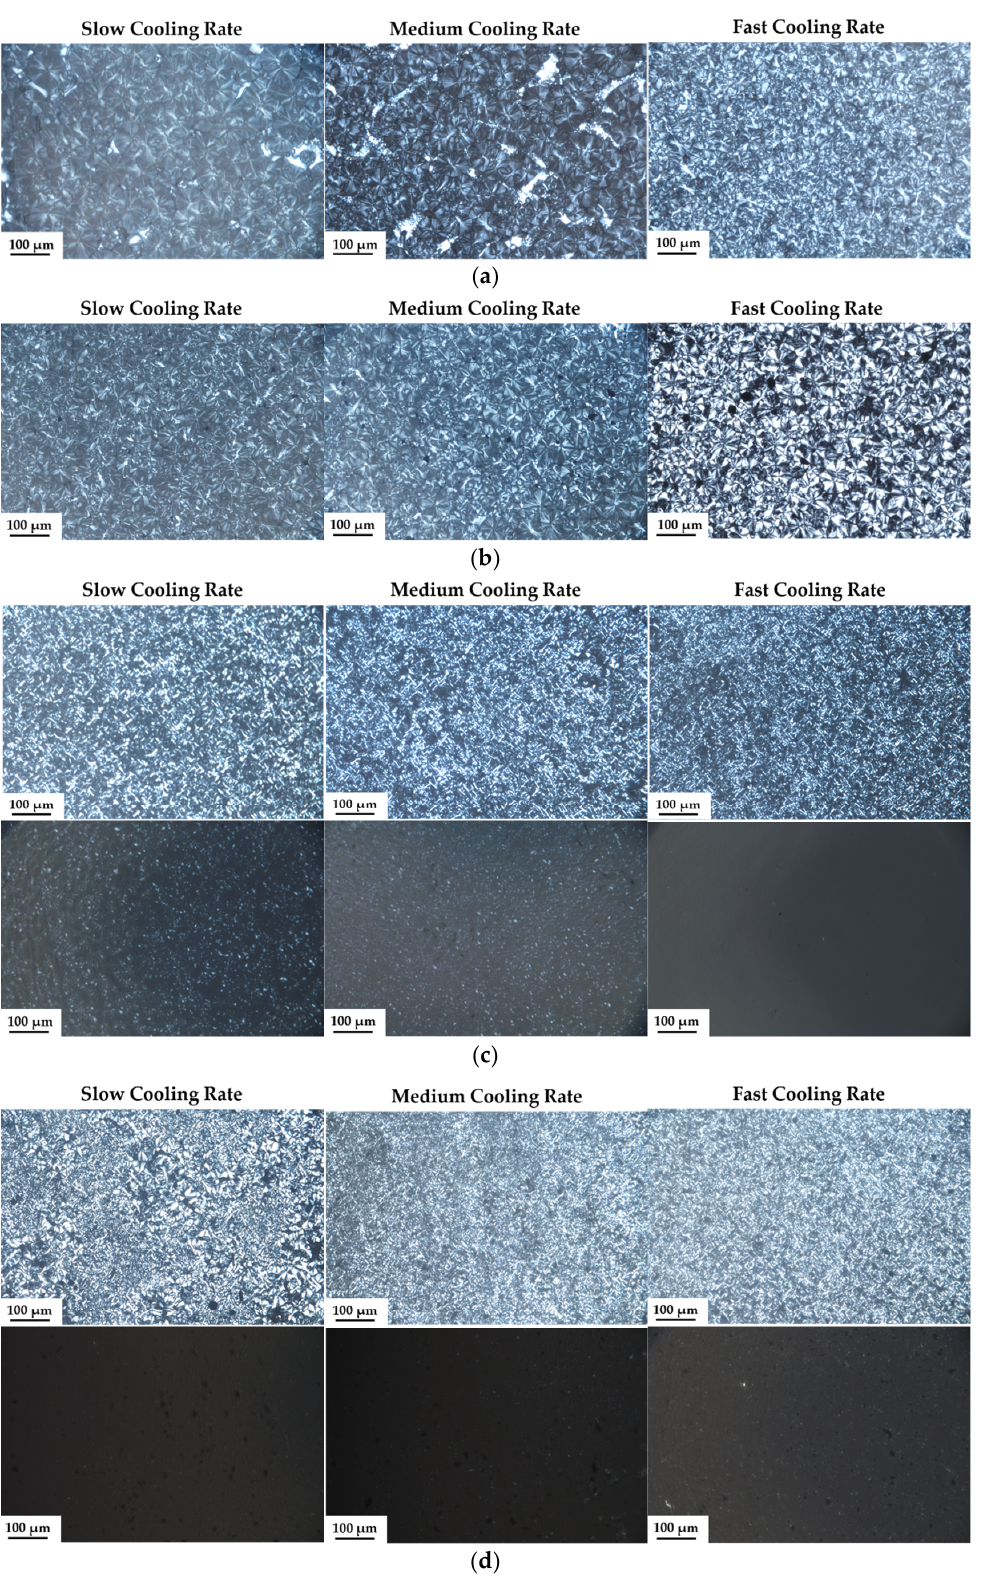
Figure 12. PLOM images of ( a ) iPP, ( b ) iPP/MXene, ( c ) iPP/ β -NA, and ( d ) iPP/MXene/ β -NA with different thermal histories. iPP/ β -NA and iPP/MXene/ β -NA were remelted to 165 ◦ C to observe the residual morphologies. The scale bar represents 100 µ